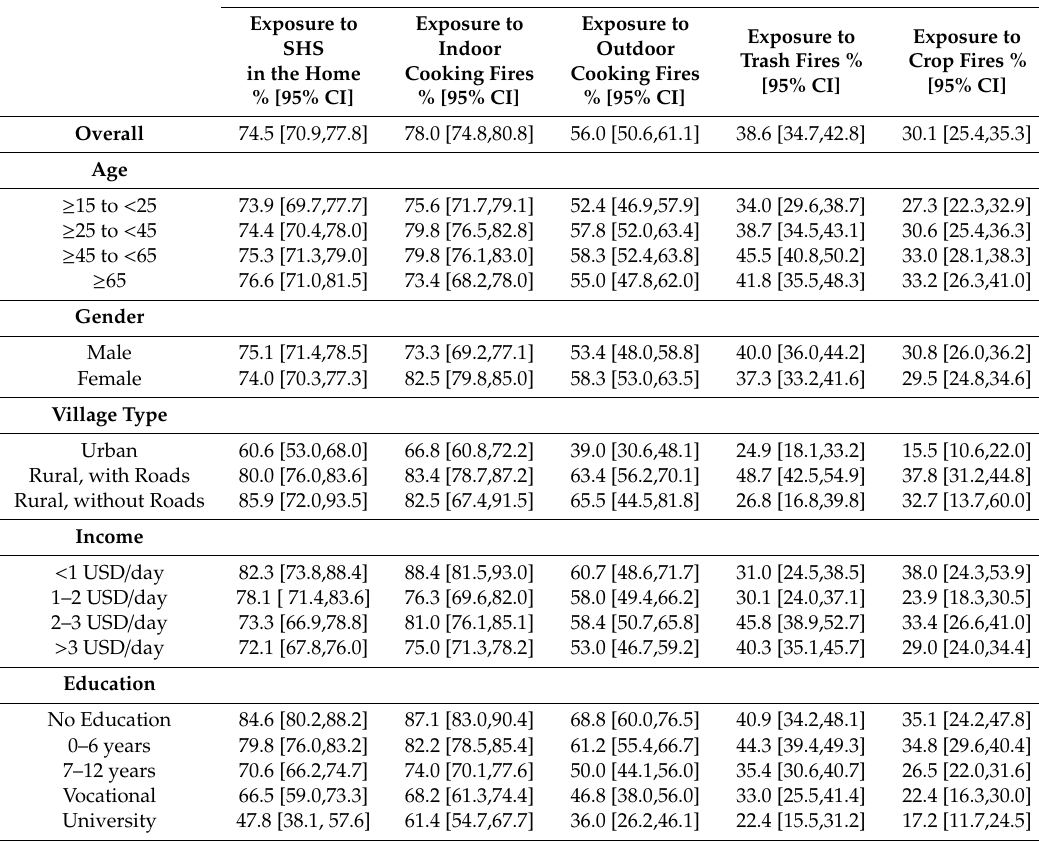
Table 1. Overall prevalence of exposure to household and community sources of air pollution (95% CI) among 9043 subjects of the 2012 National Adult Tobacco Survey of Laos (NATSL 2012) and prevalence by demographic variables [95%